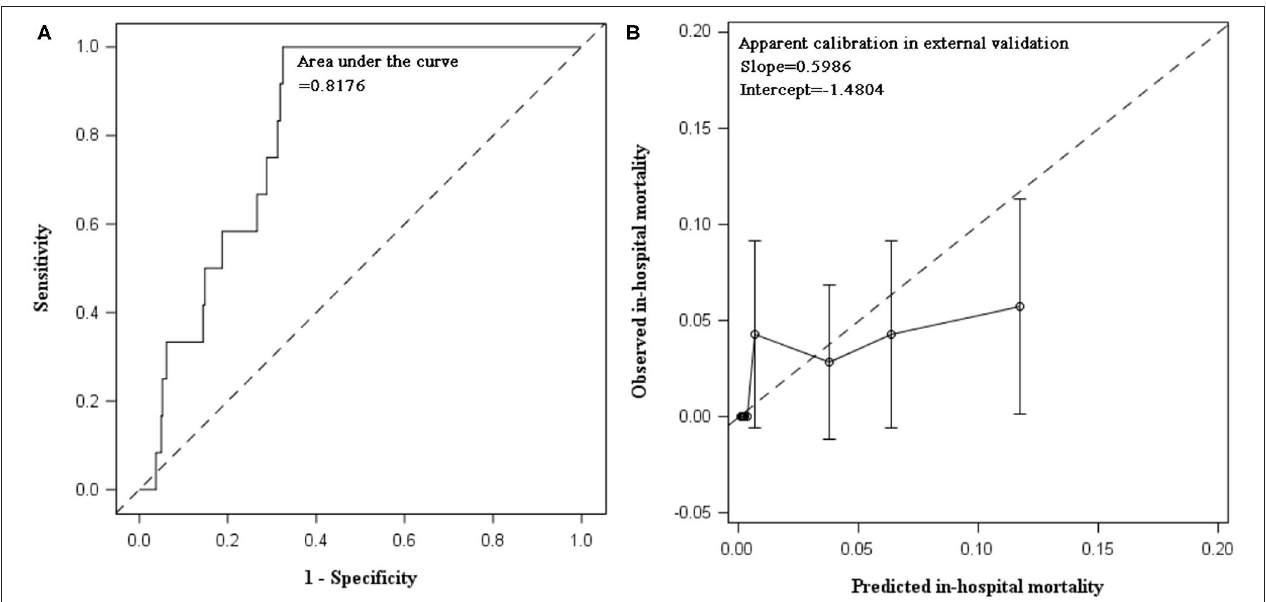
FIGURE 2 | Discrimination and calibration of in-hospital mortality prediction model in external validation using data collected between 2018 and 2019. (A) AUC of in-hospital mortality prediction model: C statistic was 0.8176 (95% CI: 0.7487, 0.8865) in patients hospitalized for AECOPD during 2018 and 2019. (B) Calibration plot of prediction model: calibration slope was 0.5986 (95% CI: 0.2409, 0.9563) and intercept was − 1.4804 (95% CI: − 2.8037, − 0.1571). Hosmer–Lemeshow test indicated poor calibration of our prediction model in AECOPD inpatients between 2018 and 2019. When stratified by predicted mortality, the prediction model was well-calibrated in low-risk patients with predicted mortality rate ≤ 10%. The Hosmer–Lemeshow test was insignificant (chi-square = 9.2052, P = 0.3253). Whereas, the death risk was overestimated in patients with predicted mortality rate greater than 10% (chi-square = 281.1386, P < 0.0001). The overall Hosmer–Lemeshow test result was significant (chi-square = 17.0856, P =